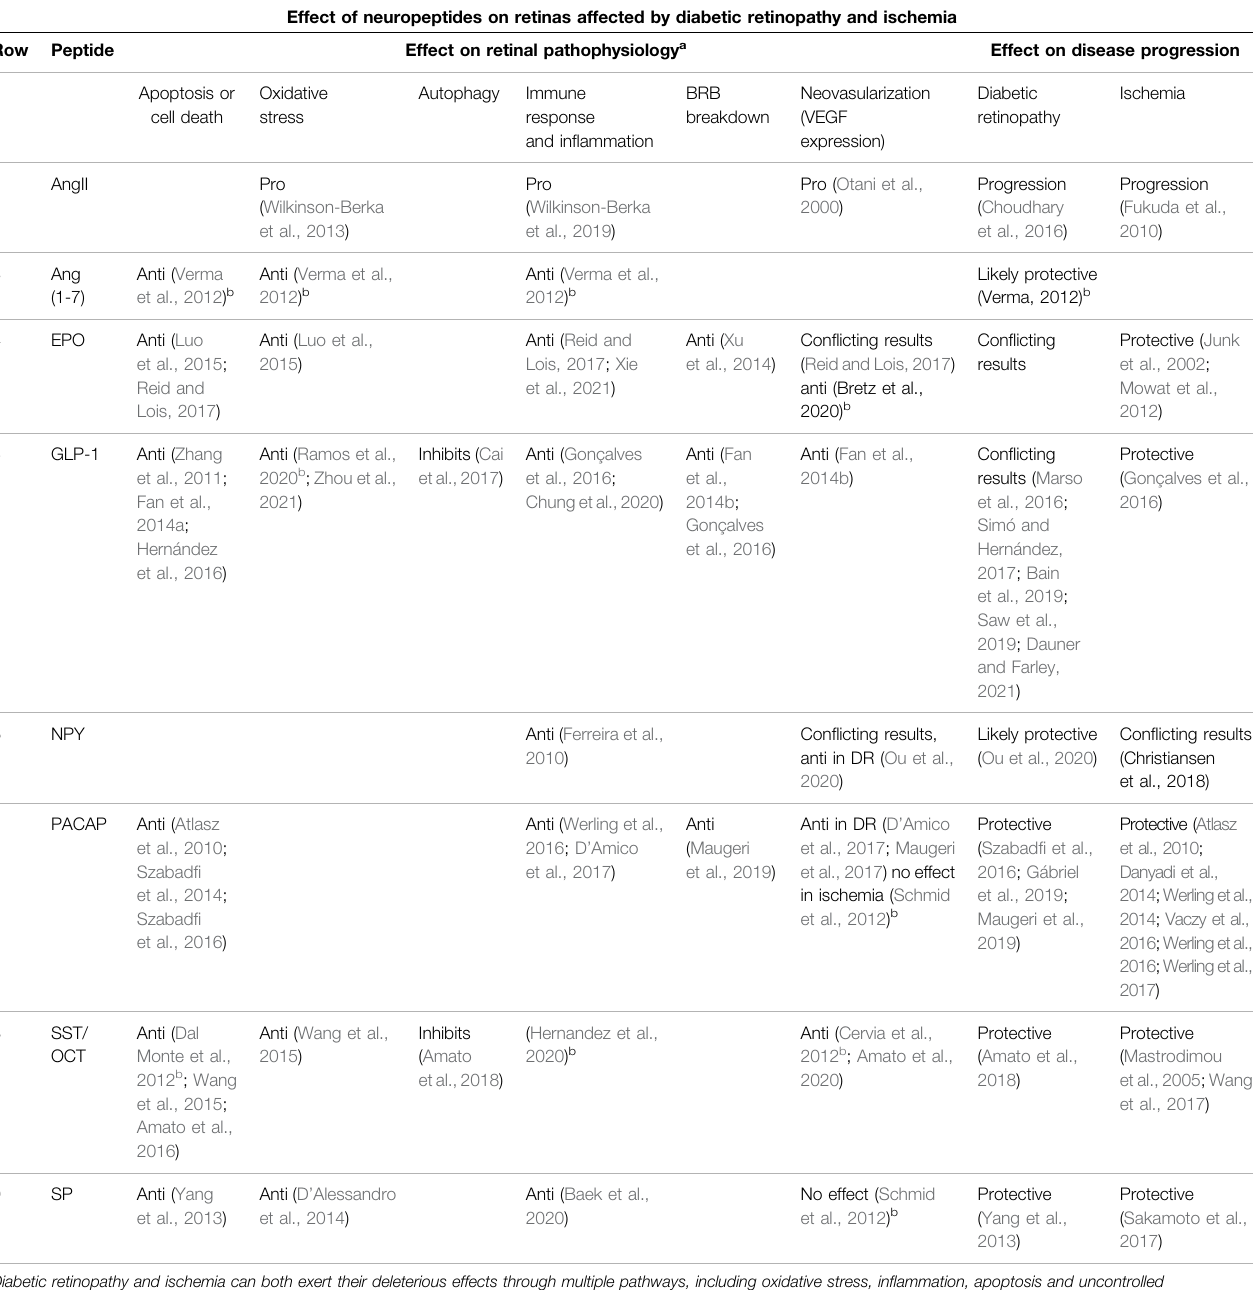
TABLE 2 | Effect of neuropeptides on retinas affected by diabetic retinopathy and ischemia. Effect of neuropeptides on retinas affected by diabetic retinopathy and